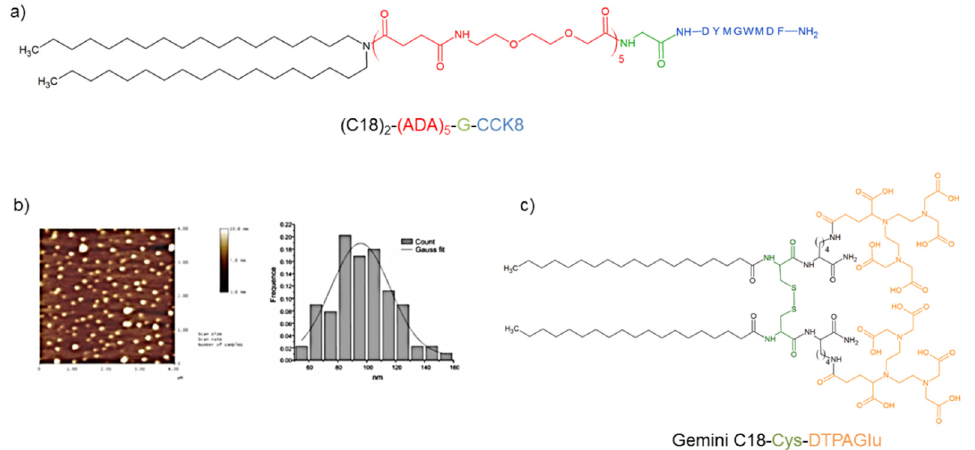
Figure 3. Chemical representation of: ( a ) (C18) 2 (ADA) 5 -G-CCK8, ( b ) AFM microphotos of peptide amphiphile-based aggregates (1 × 10 − 5 mol/kg) and relative diameter histogram distribution (reprinted with permission from [58]), ( c ) gemini C18-Cys-DTPAGlu.